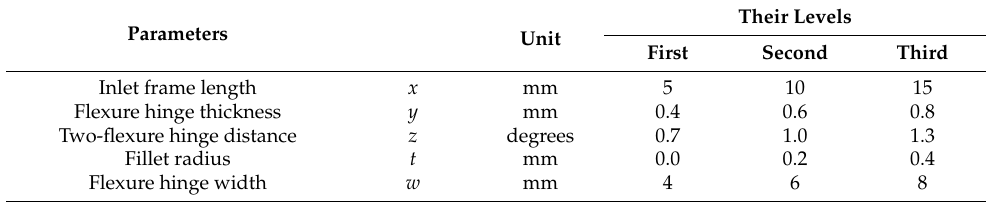
Table 1. Selected factors with their